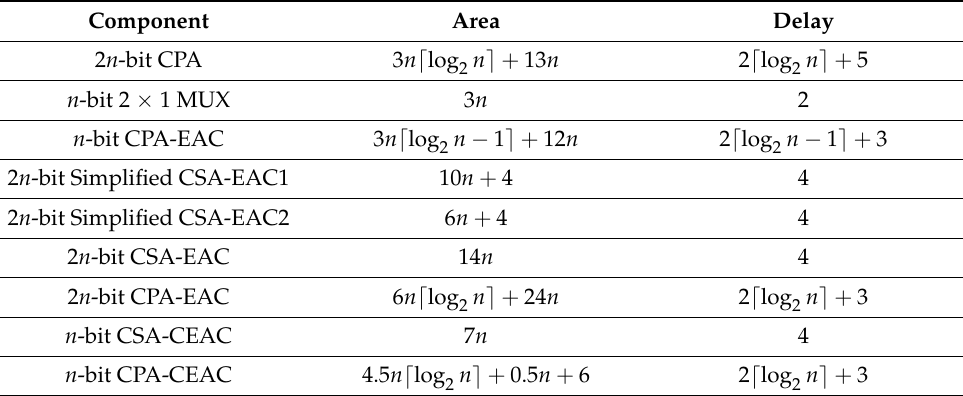
Table 2. The area and delay formulas based on the U-G model for different components of the pro- posed double-modulo scaler.